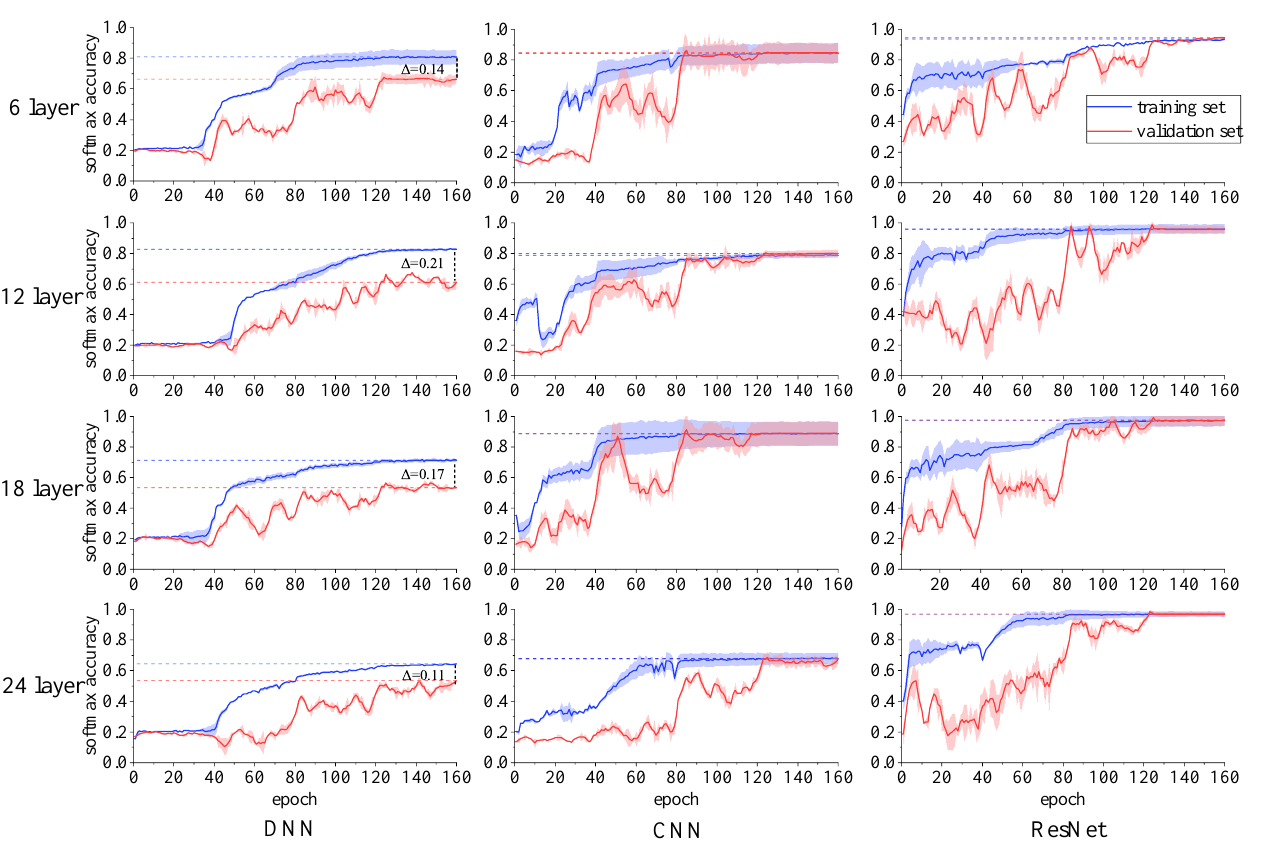
Figure 8. Training accuracy curve of deep learning network. The horizontal line represents the comparison between different networks, the vertical line represents the comparison between networks of different depths, and the filled area represents the standard deviation of ten trainings, to measure the stability of training.The dotted line indicates the reference